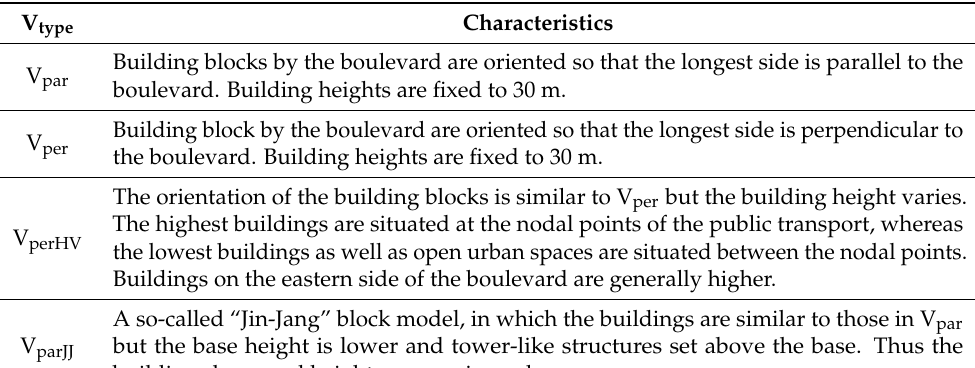
Table 2. The specific characteristics of different city-block-design